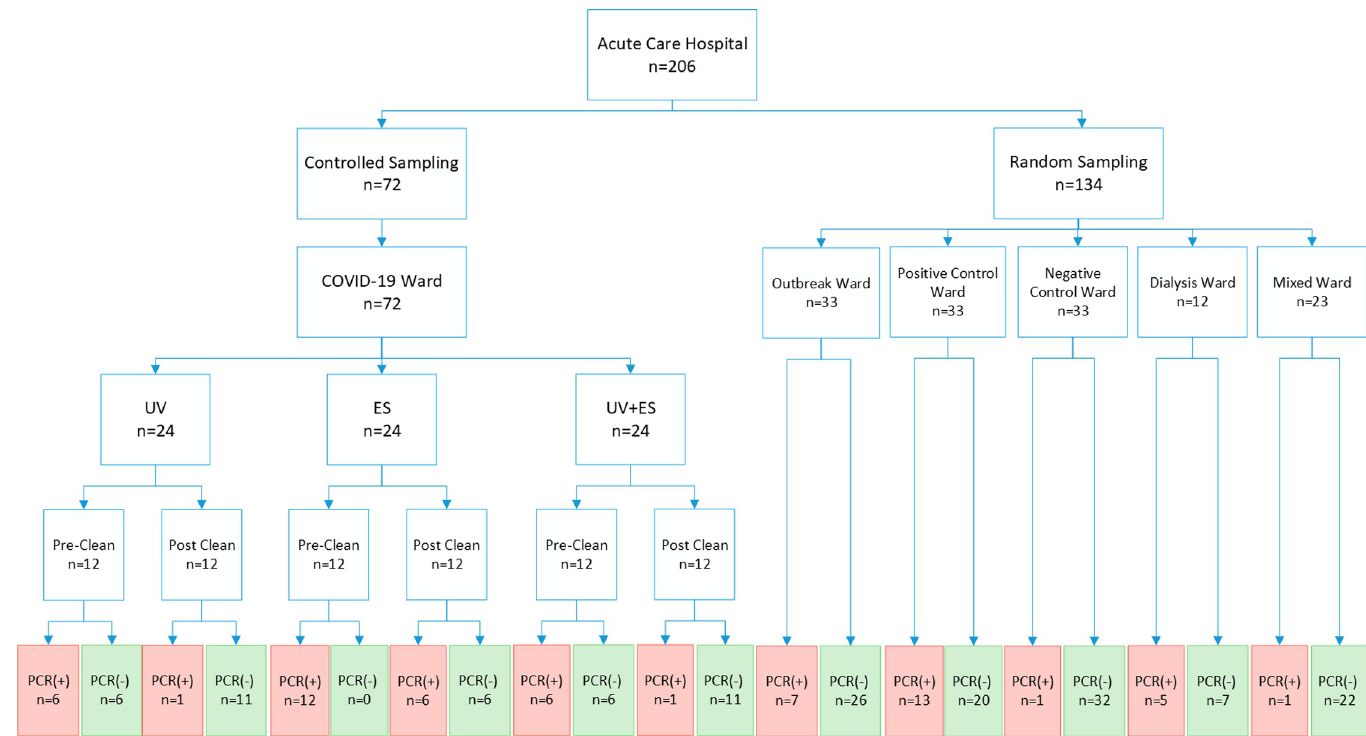
Fig 2. Sample breakdown at the acute care hospital. Legend: ES = Electrostatic spray; UV light = Ultraviolet light.